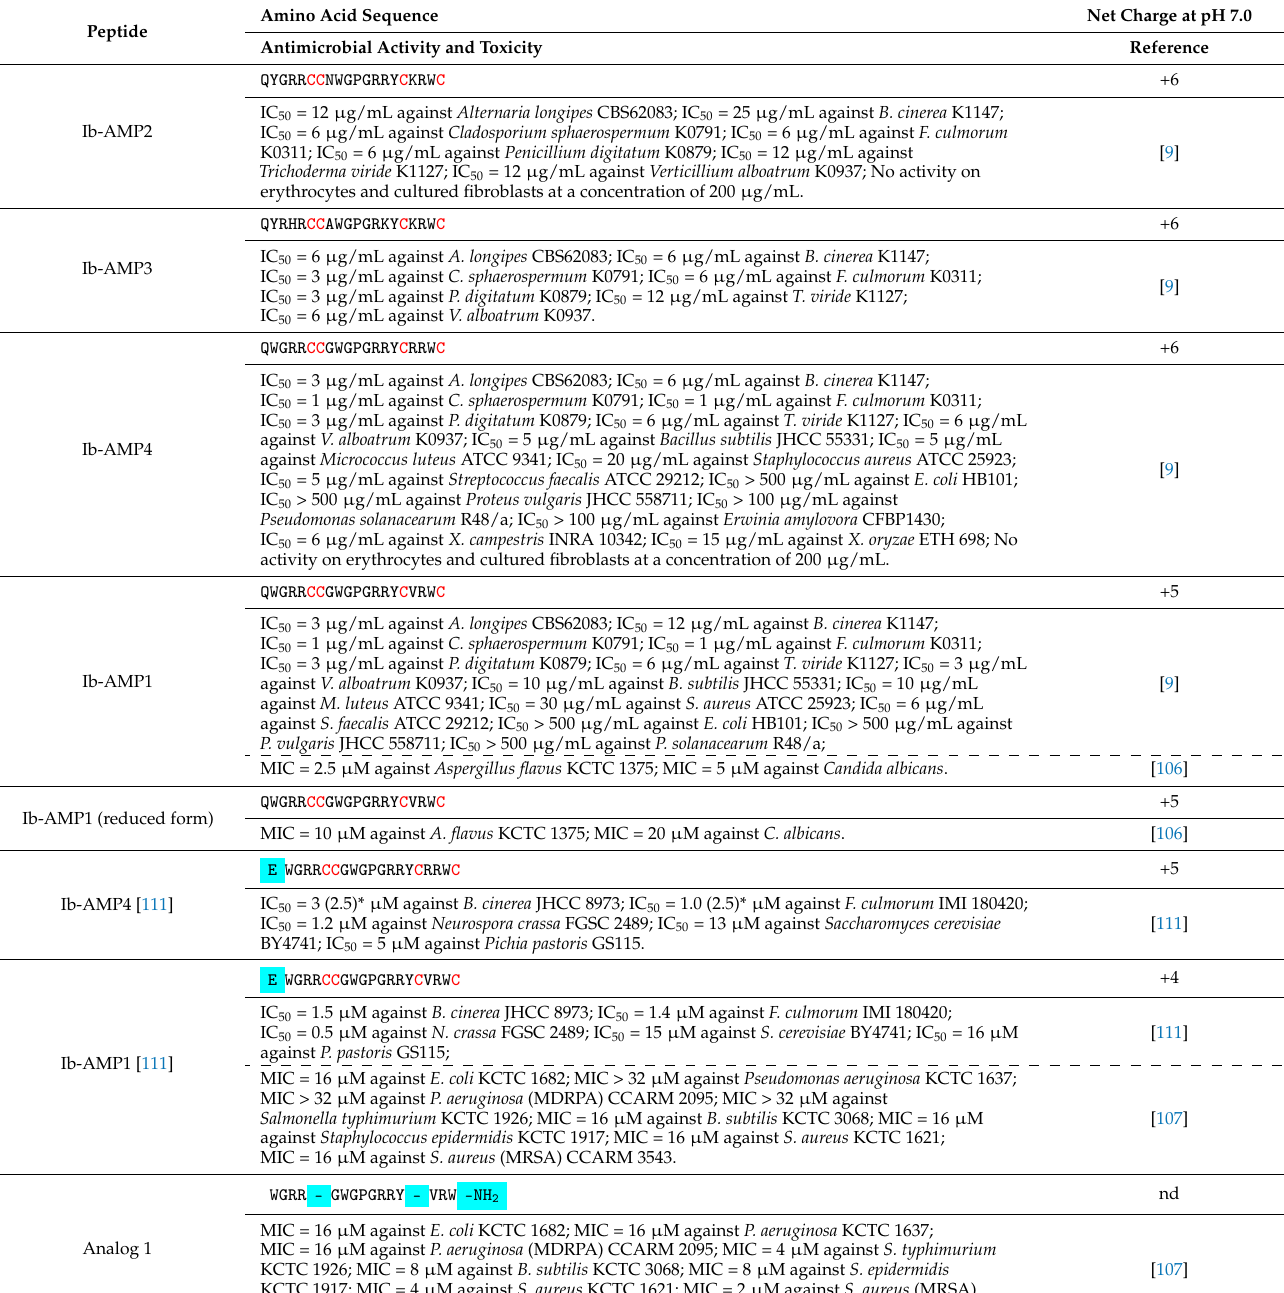
Table 4. Ib-AMP1-4 and derived peptides: sequence, net charge at pH 7.0, and antimicrobial activity. Cysteine residues are shown in red, and substituted amino acids are highlighted in cyan. Gaps ( − ) were introduced to improve the alignment. Note: nd—not determined; *—both figures are given in the original article; a —Ala peptoid residue (Nala) (CH3–NH–CH2–COOH); k —Lys peptoid residue (Nlys) (NH2–CH2–CH2–CH2–CH2–NH–CH2–COOH); <E—pyroGlu; B— α -amino butyric acid; L- and D-amino acids are indicated by capital and small letters,